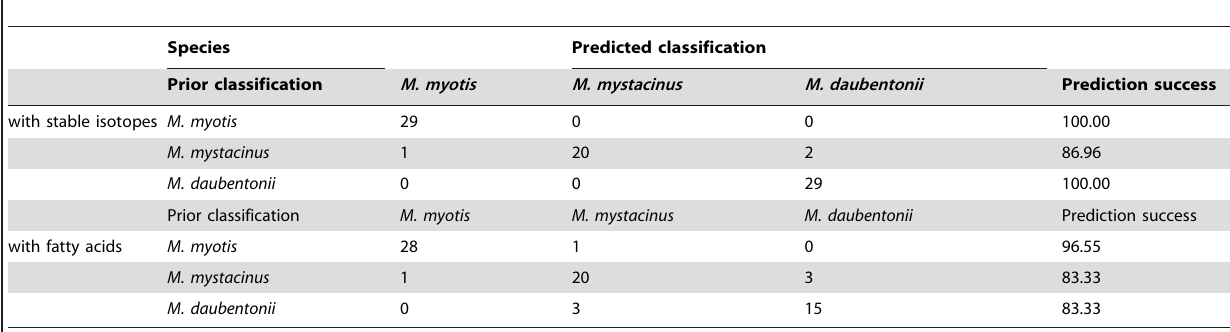
Table 5. Results of the linear discriminant function analysis for the stable isotope ( d 15 N, d 13 C, d 34 S) and fatty acid data (total v 3 and v 6 PUFAs and v 3/ v 6 ratio).